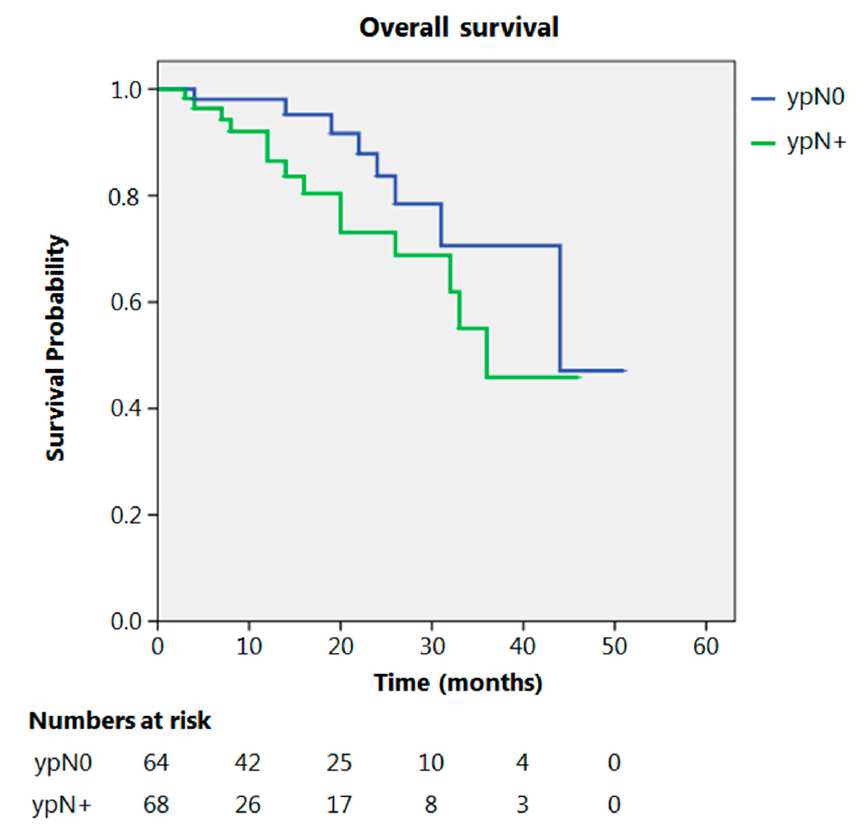
Figure 4. Overall survival according to ypN .